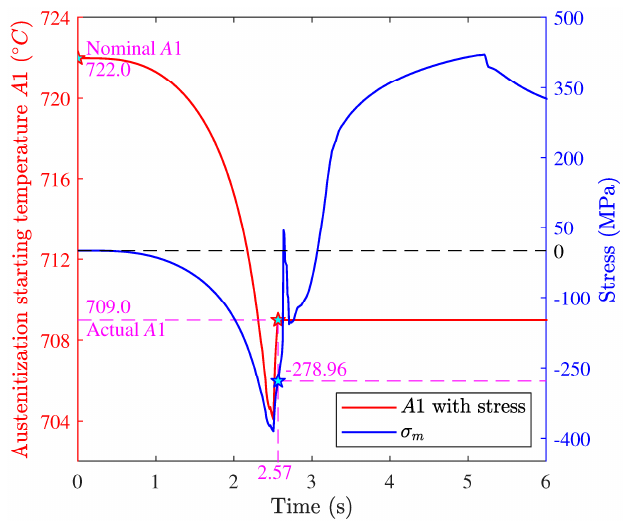
Figure 10. Hydrostatic stress histories and 1 A with stress.